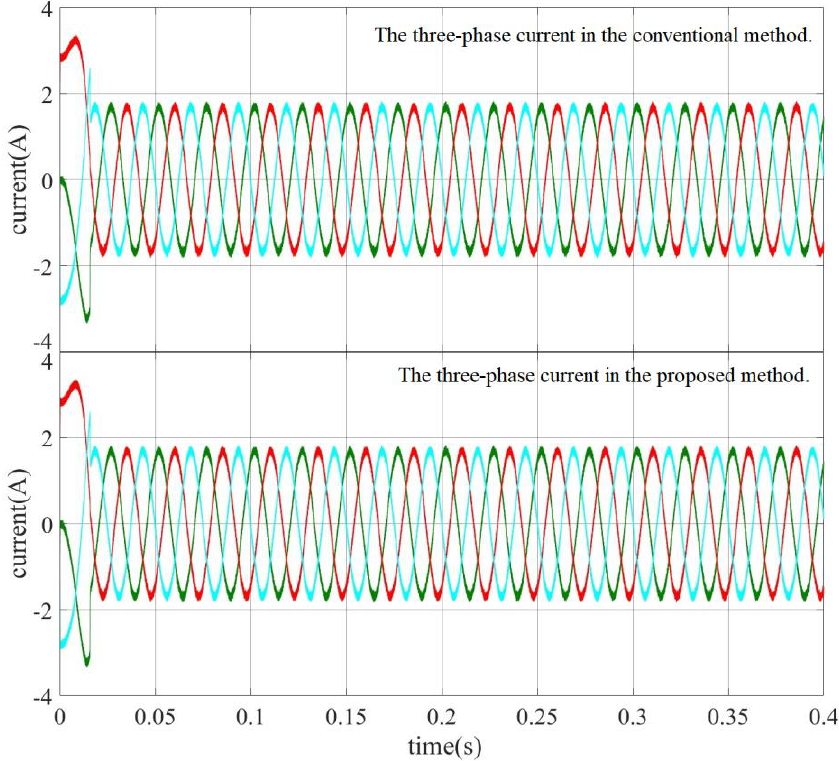
Figure 8. Three-phase current waveforms when the motor is under load.